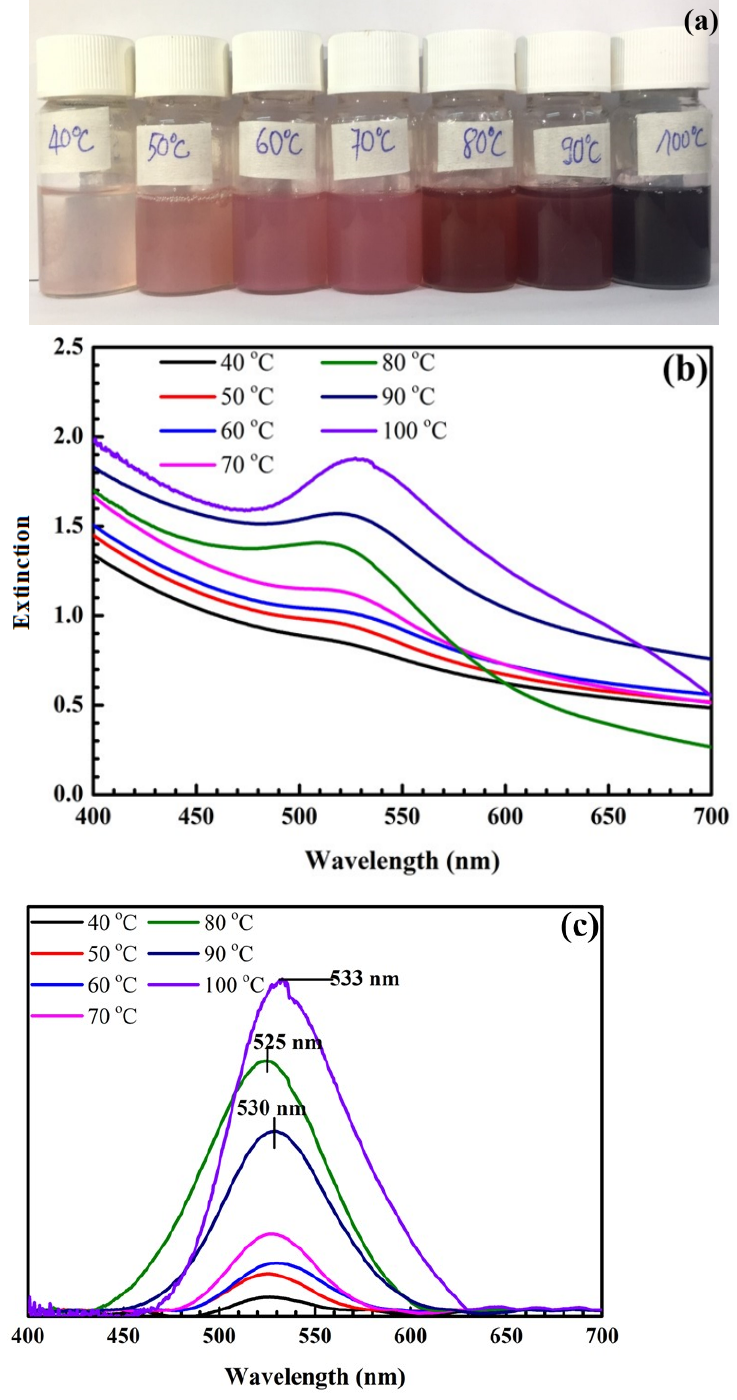
Figure 1. Pictures of samples at different temperatures ( a ). UV-Vis spectra of samples at different temperatures ( b ) and their UV-Vis baseline spectra ( c ).